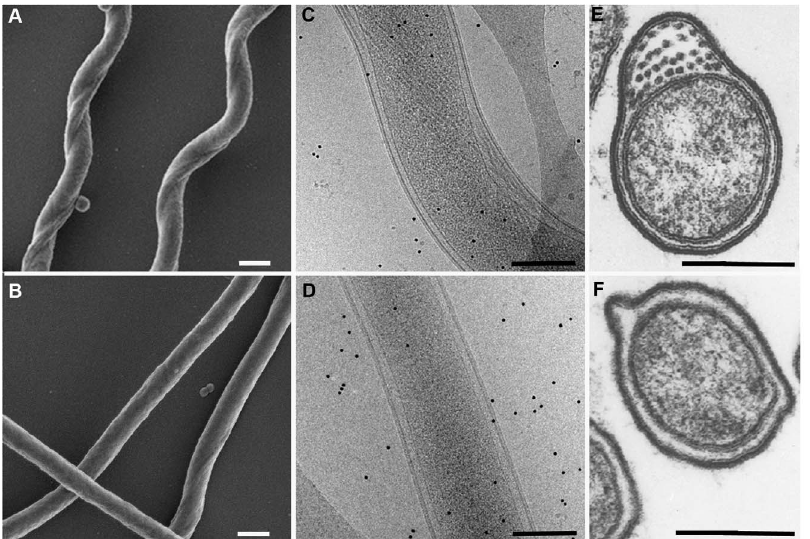
Figure 2. Electron microscopic (EM) analyses of parental wild-type B.hermsii and non-motile mutant. (A–F) The morphology of the mutant is strikingly different than the wild-type B. hermsii . By Scanning EM, the wild-type cells show the typical flat-wave morphology (A) compared to the straight shape of the non-motile mutant (B). By Cryo-EM, the wild-type spirochetes show the normal shape and numerous periplasmic flagella (C) compared to the mutant that is straight with few or no periplasmic flagella (D). Cross-sections viewed by transmission EM also show numerous flagella in the periplasmic space of the parental wild-type spirochetes (E) compared to none in the example of the non-motile mutant of B. hermsii shown here (F). All scale bars represent 0.2 m m.